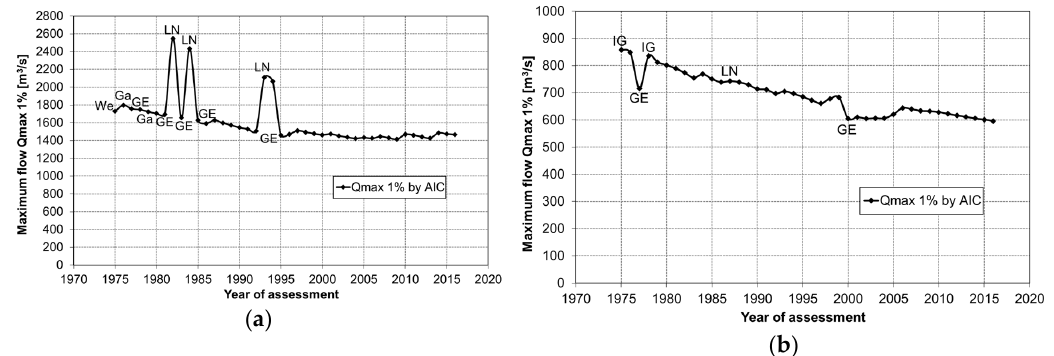
Figure 4. Estimates of the 1% quantile of maximum flows at Proszówki Station along with the best matching distributions for: ( a ) summer season; ( b ) winter season. Distributions: Ga – gamma, We – Weibull, GE – generalized exponential, IG – inverse Gaussian, LN – log-normal.